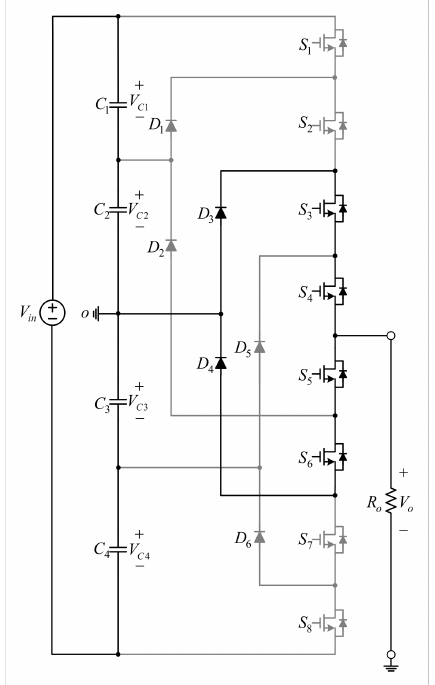
Figure 3. Zero voltage output of a five-level neutral point clamped inverter. Status II [ V o = 0.5 V in or − 0.5 V in ]: When the switches S 1 , S 2 , S 3 , and S 4 are on and S 5 , S 6 , S 7 , and S 8 are off, the circuit is displayed in Figure 4a, and the output voltage is 0.5 V in . When the switches S 5 , S 6 , S 7 , and S 8 are on and S 1 , S 2 , S 3 , and S 4 are off, the circuit is displayed in Figure 4b, and the output voltage is − 0.5 V in